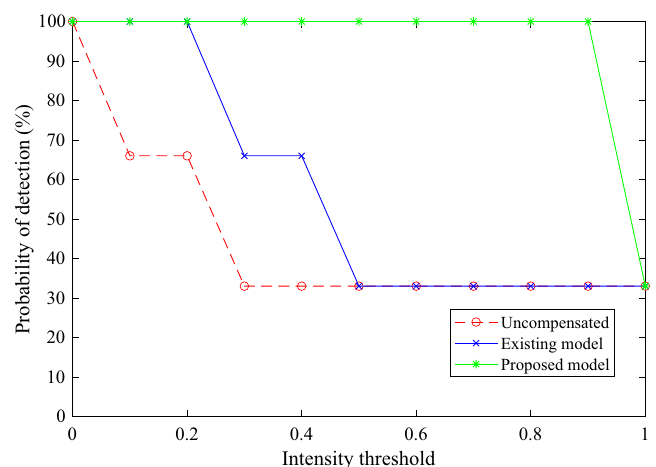
Fig. 10 PPD vs intensity threshold using DSBF for three target